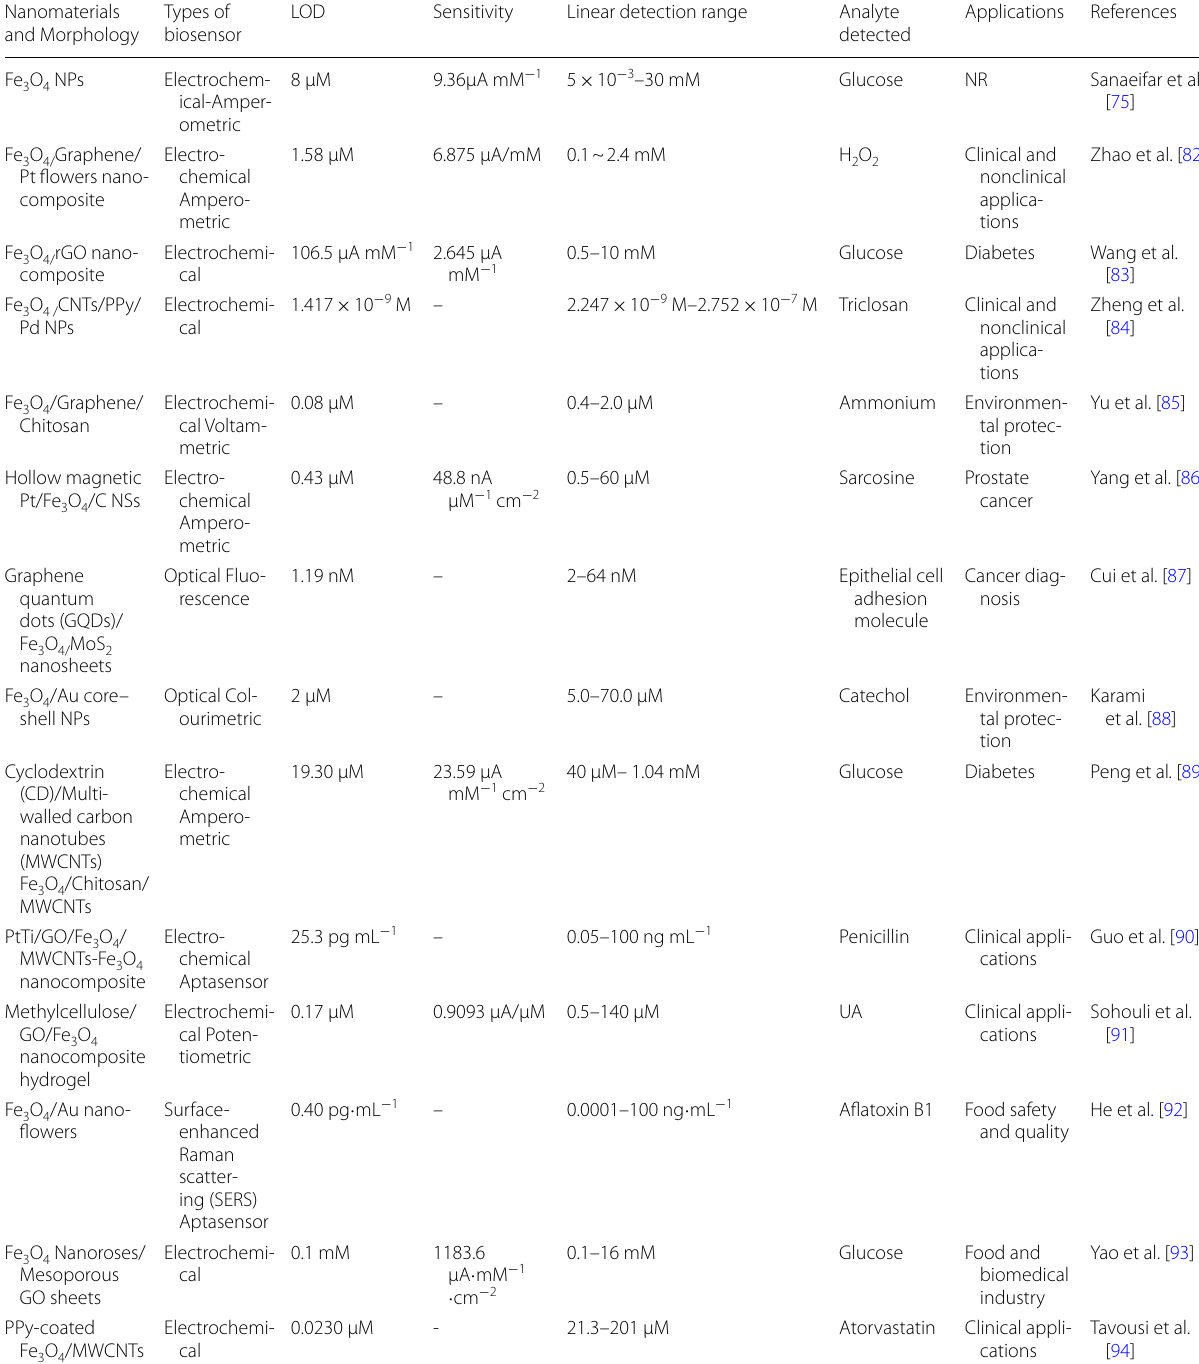
O nanostructures 3 4